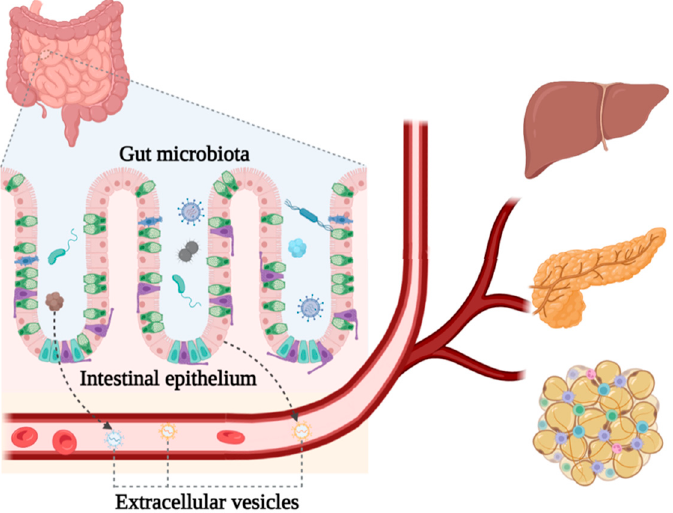
Figure 1. Gut-derived extracellular vesicles may participate in the regulation of lipid and glucose metabolism in remote organs. Extracellular vesicles originating from either intestinal epithelial cells or gut microbiota contain molecules that take part in the fine-tuning regulation of glucose and lipid homeostasis in liver, pancreases, and adipocytes.